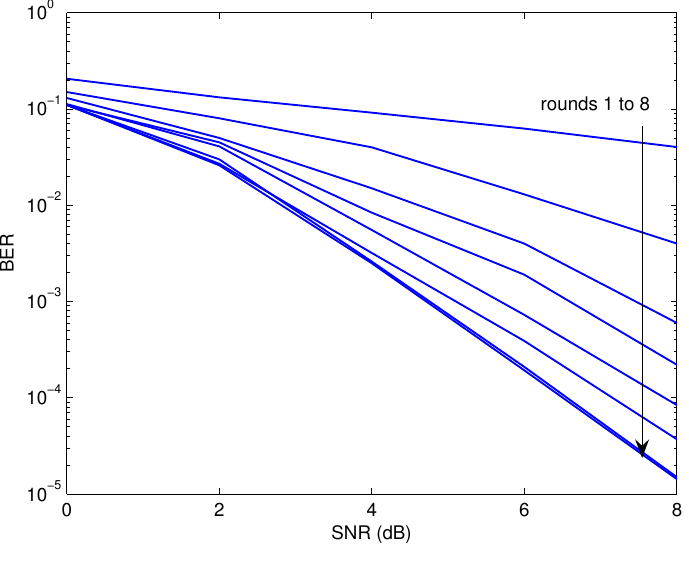
Figure 3. BER of the proposed